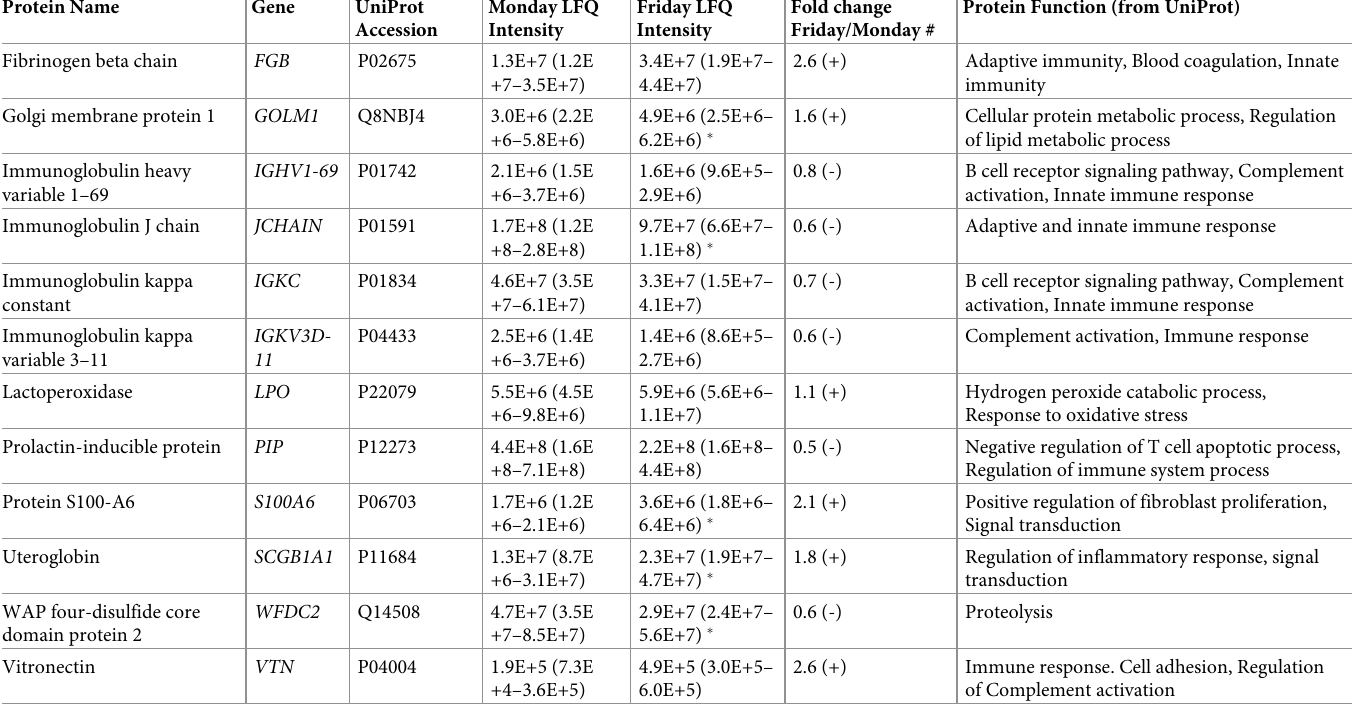
Table 2. Proteins obtained from orthogonal partial least squares-discriminant analysis when comparing additive manufacturing operators Monday vs Friday year1. Protein